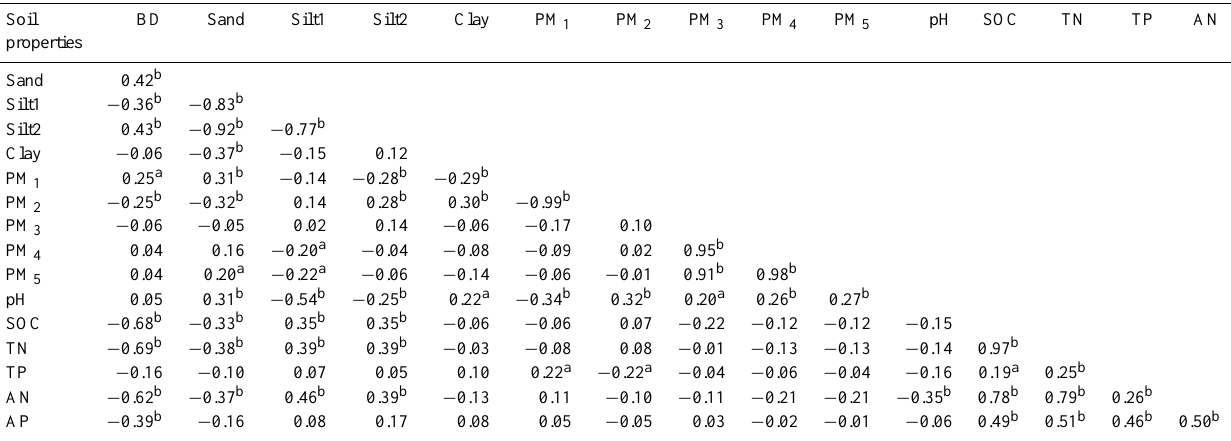
Table 3. Pearson’s correlation coefficients among soil property and nutrient indicators of alpine grasslands and their significance